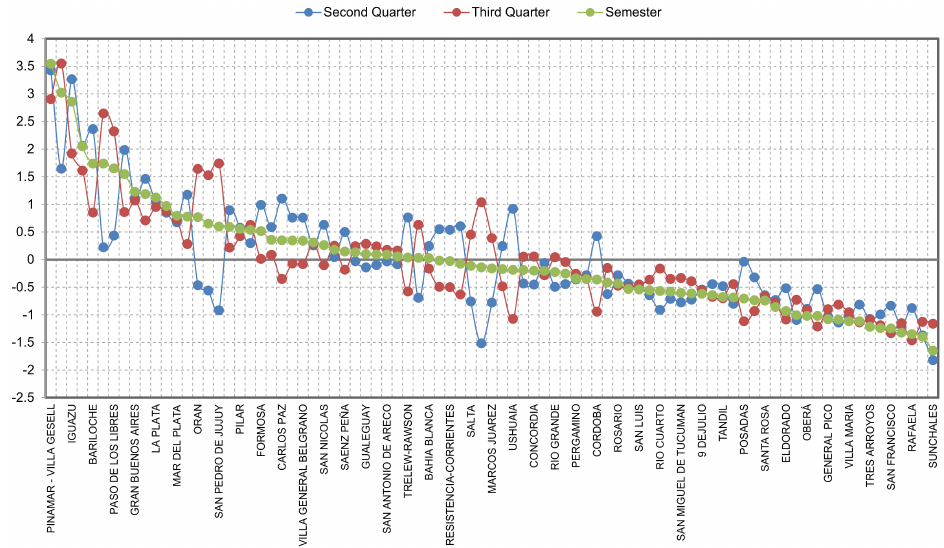
Figure 4: ITEI for LMAs: standardized values per quarter and